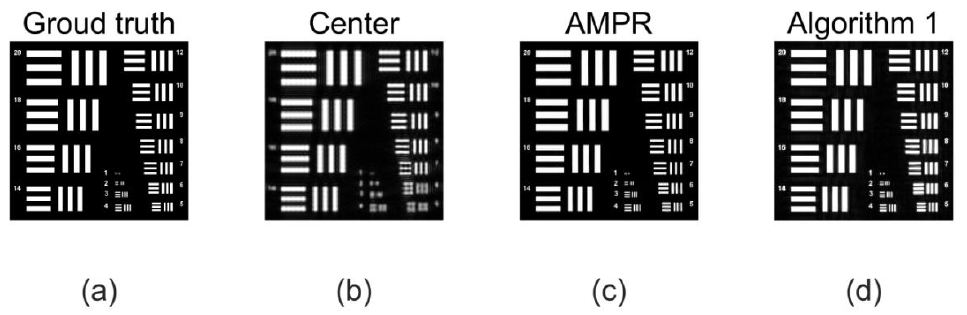
Figure 11. Experimental results using camera sub-sampling, 50% cameras are active ( a ) Ground truth: we simulate imaging a 64 × 64 mm resolution target 50 m away using the sensor with a pixel pitch of 2 µ m. ( b ) Center image: SSIM = 0.3198. The image is acquired by the intermediate camera. The aperture is scanned over a 17 × 17 grid (70% overlap) creating a synthetic aperture of 104.4 mm synthetic aperture ratio (SAR) is 5.8, ( c ) AMPR: SSIM = 0.4384. The output of phase retrieval is obtained using the AMPR algorithm. ( d ) Algorithm 1, SSIM = 0.8899. The output of phase retrieval is obtained using Algorithm 1. We can see that Algorithm 1 is improved from 0.4384 to 0.8899 compared to the algorithm